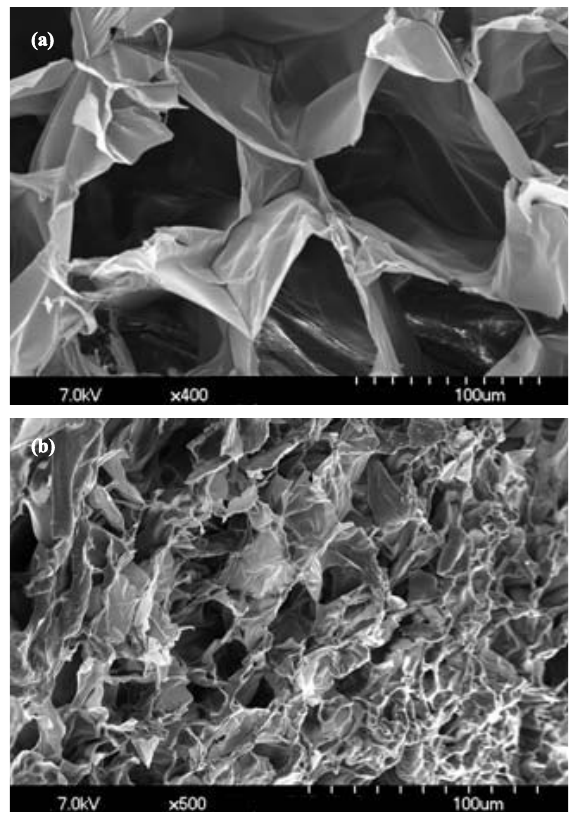
Figura 2. Micrografia da superfície de hidrogel de PAAm (a) 3,6 % (ampliação de 400 X) e (b) 21,7 % de AAm (ampliação de 500 X).